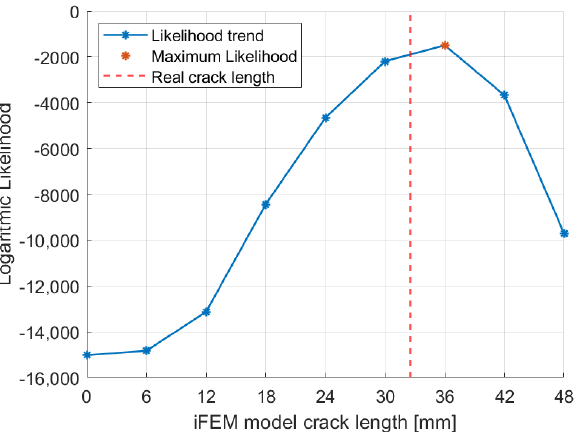
Figure 13. Likelihood trend for experimental strain acquired at 32.5 mm crack length.